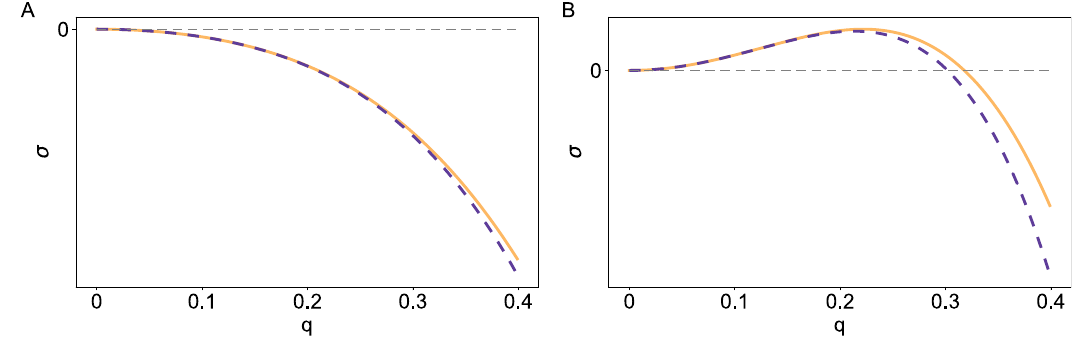
Fig 1. Growth rate σ + as a function of the wavenumber q . Comparison between the full solution in Eq (14) (solid line) and its Taylor expansion up to the order q 4 given by Eq (15) (dashed line) at the critical point ε = 0 (A) and slightly above ε = 0.1 (B) (for a 2 =